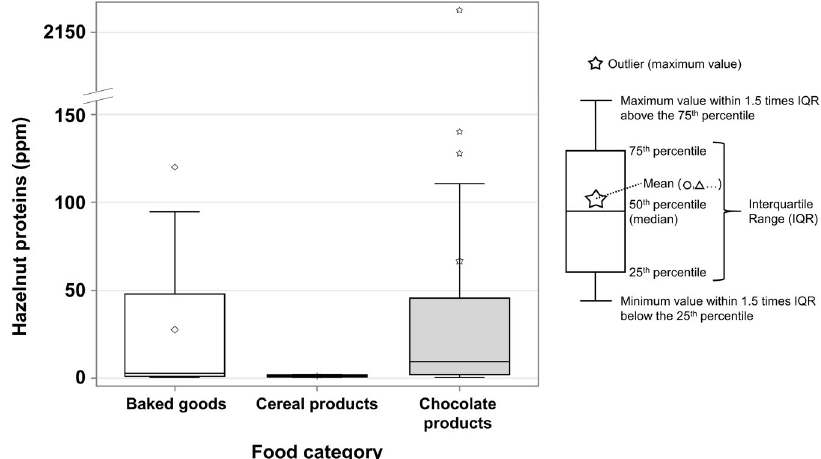
Fig. 4 Hazelnut protein concentration by food category. Each box corresponds to a different food category and has a different color-symbol combination. The “ Baked goods ” category has one outlier, while “ Chocolate products ” has three with its mean between the 75 th percentile and the upper whisker. The other food categories (Baking mixes, Candies, Cookies, Savoury biscuits, Snacks) had no positive results for